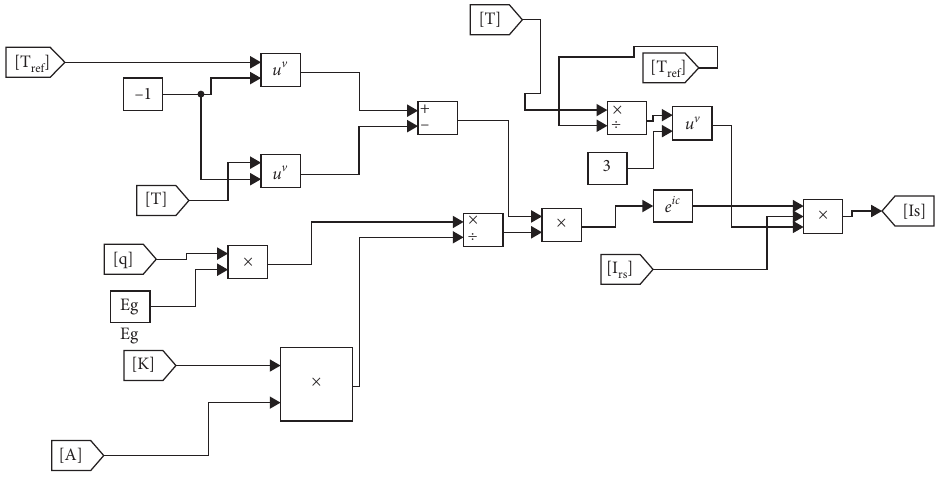
at the node. sat